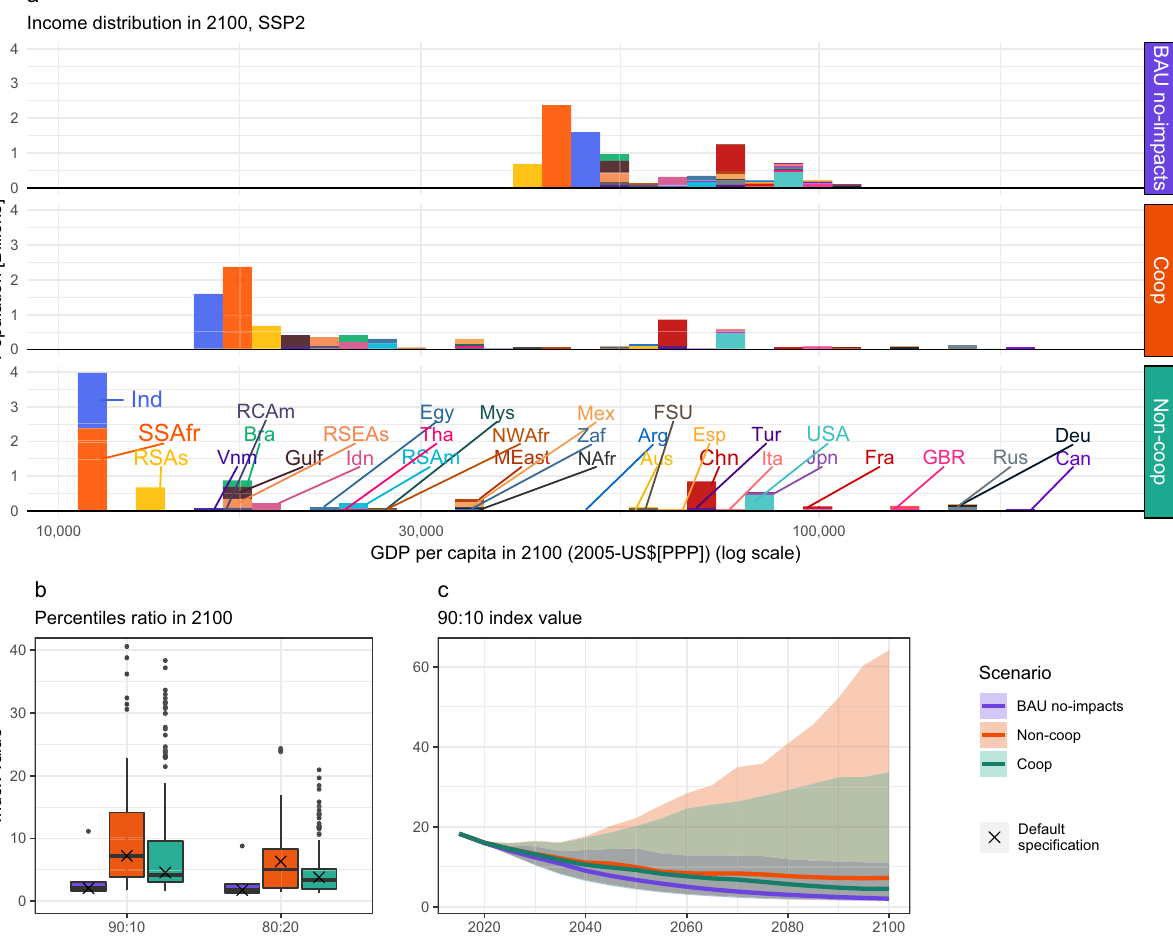
Fig. 4 Income distribution and inequality indexes. a GDP per-capita, net of costs and impacts, population-weighted distribution in 2100 under our default speci fi cation. b 90:10 and 80:20 inequality index (percentile-ratios over population-weighted distributions), in 2100, of all scenarios. Year 2020 values are 15.9 (90:10 ratio) and 3.2 (80:20 ratio). c 90:10 index evolution over time among all scenarios (The scenarios based on the SSP2 pathway are shown as solid